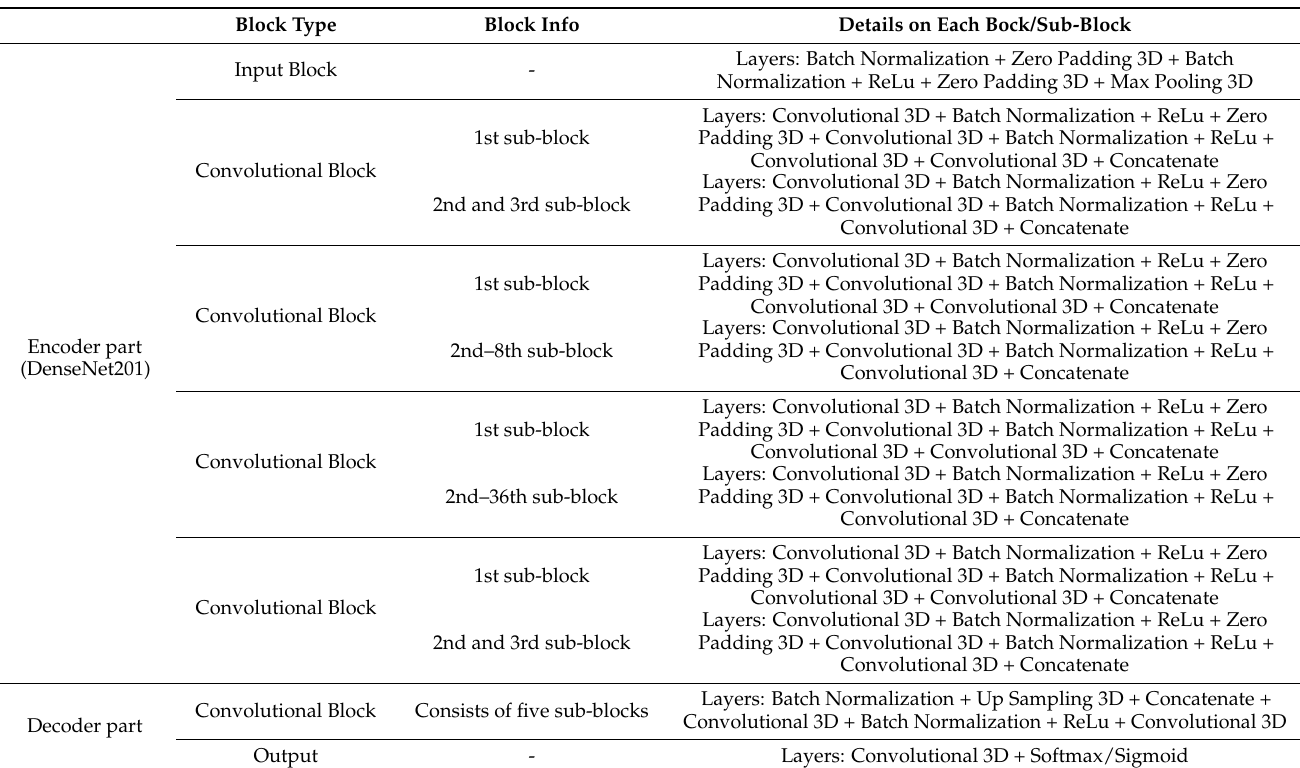
Table A2. Details on 3D ResUNet